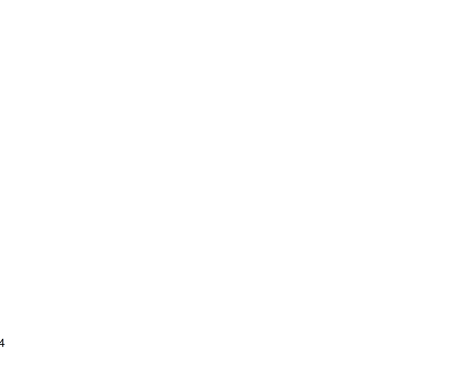
Table 5. Results from the IMD simulations of the XRR measurements as shown in Fig. 10 (bottom row) as well as from reference measurements of non-processed samples (top rows). ( * ) Surface roughness values from interference microscopy.